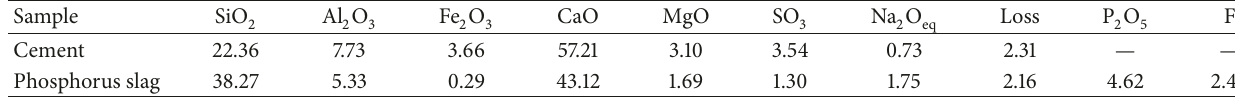
Table 1: The chemical compositions of the raw materials%.